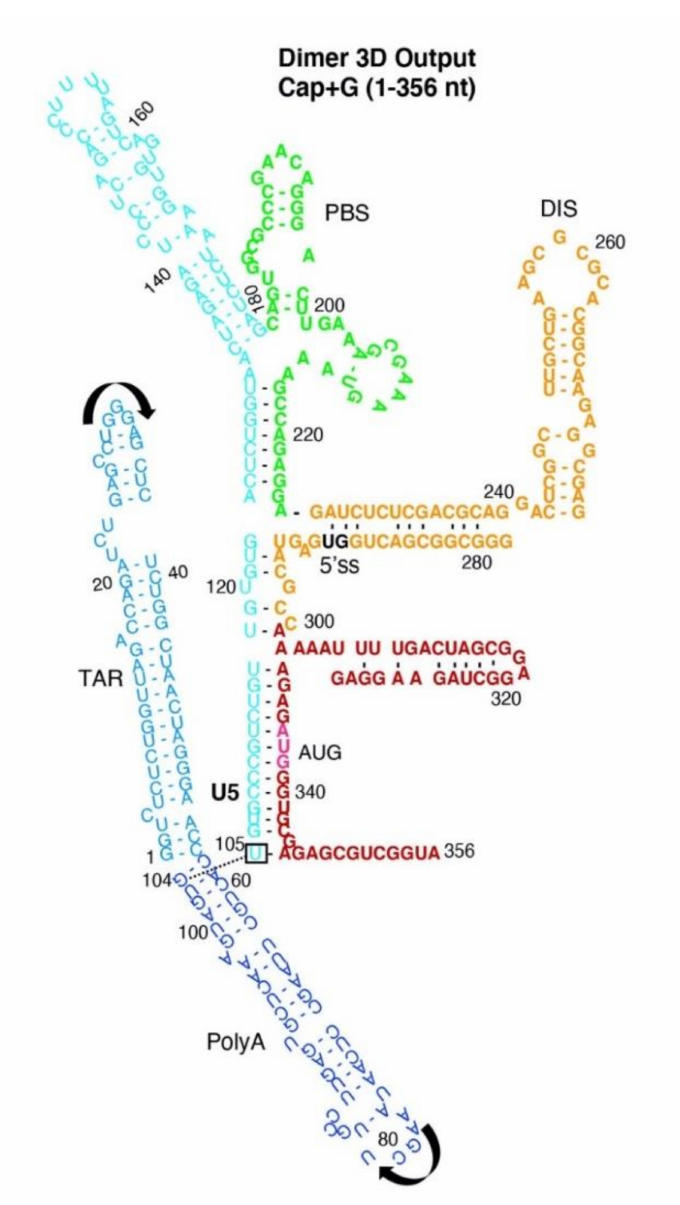
Figure 3. 2D rendering of SimRNA 3D Dimer Model. Arrows represent the orientation of TAR and PolyA helices. Box and dashed line indicates stacking of G104-U105. Label colors: TAR, light blue; PolyA, navy; U5 stem, cyan; PBS-segment, green; DIS stem, orange; AUG stem, red; 5 (cid:48) -splice site (5 (cid:48) ss), black; AUG translation start codon,